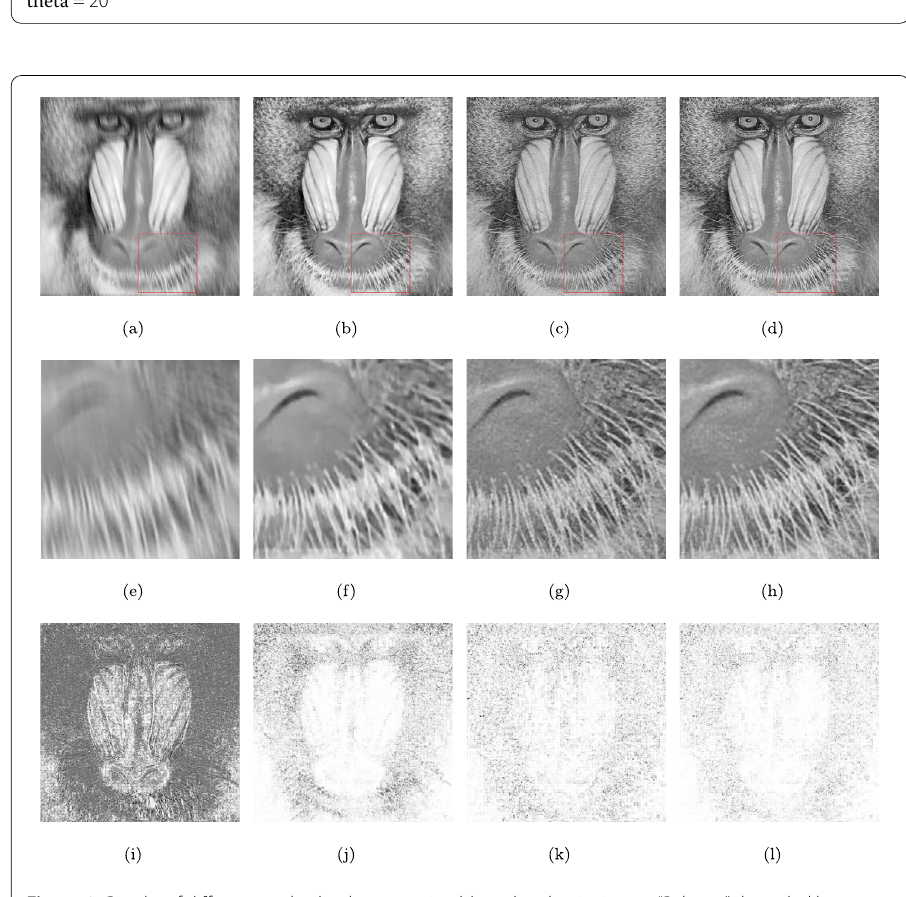
Figure 8 Results of different methods when restoring blurred and noisy image “Baboon” degraded by motion blur with len = 10 and theta = 100 and a noise with BSNR = 35: ( a ) blurred and noisy image; ( b ) restored image by FastTV; ( c ) restored image by FNDTV; ( d ) restored image by our method; ( e ) zoomed part of ( a ); ( f ) zoomed part of ( b ); ( g ) zoomed part of ( c ); ( h ) zoomed part of ( d ); ( i ) SSIM index map of the corrupted image; ( j ) SSIM index map of the recovered image by FastTV; ( k ) SSIM index map of the recovered image by FNDTV; ( l ) SSIM index map of the recovered image by our